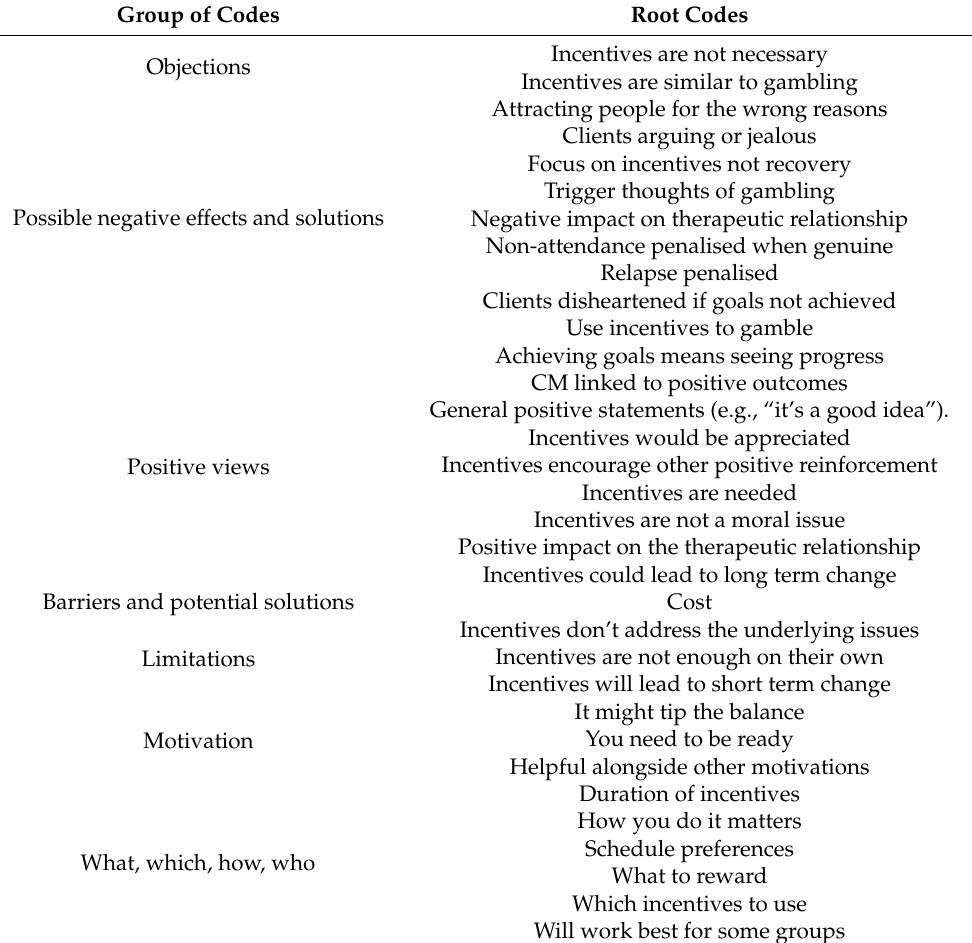
Table 1. Root codes for clients’ views of contingency management for gambling (more than 2 people contributed to each